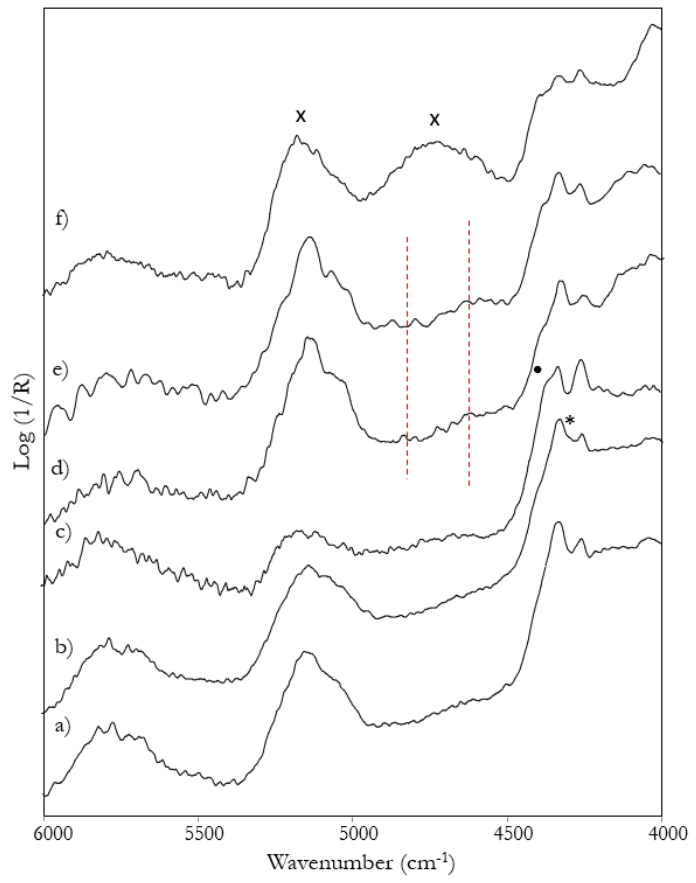
Figure 9. FT-NIR spectra from some details of the paintings ( a ) “Madonna and Child” by G. A. Boltraffio; ( b ) “Madonna and Child” by F. Galli; ( c ) “Madonna nursing the Child” by Lombard school painter; ( d ) “St. Augustine and St. Jerome” by Bergognone; ( e ) “St. John the Baptist” by B. Zenale. The red dashed lines mark the weak bands associated with egg tempera. Bands due to paper in spectrum ( f ) are marked with